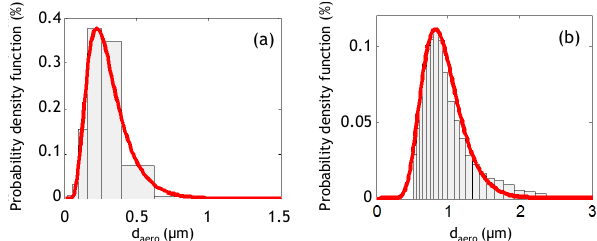
Figure 8. The size distribution of the particles produced by the ul- trasound aerosol generator vibrating at 2400kHz (a) for a fluores- cein concentration of 0.11gL − 1 and (b) for a fluorescein concen- tration of 10gL − 1 . The distribution on the left is measured using an electrical low-pressure impactor (ELPI, δ ) and the one on the right using an aerodynamic particle sizer (APS, χ